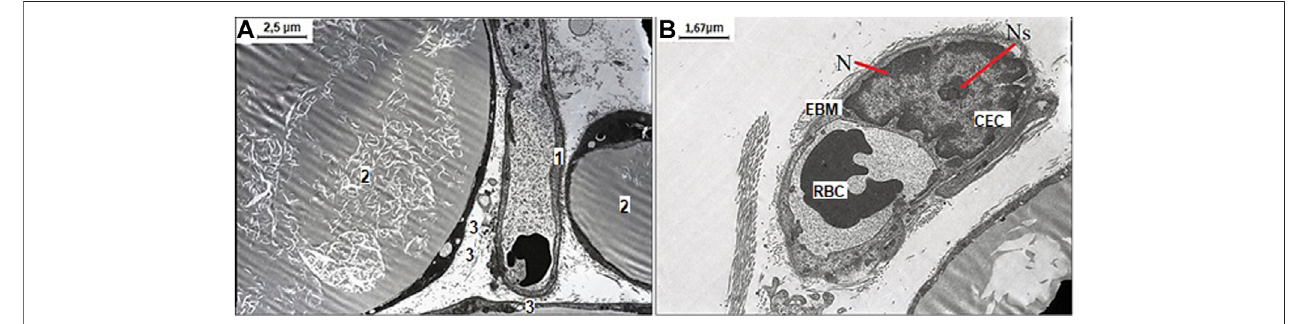
FIGURE4| RepresentativepicturesoftheeffectofNaHSfructose-fedandstressinductiononultrastructuralexaminationofmesentericmaterialharvestedfromthe area associated with the small intestine of aged rats. (A) The well-preserved capillary 1) between three white monovacuolar adipocytes 2) with single lipid droplets 3) (original magni fi cation × 4,000). (B) The capillary with the endothelial cells (CEC) with an optimally developed nucleus (N) and nucleolus (Ns), and thickened and edematous basal membrane (EBM) with altered red blood cell (RBC) in its lumen (original magni fi cation × 6,000).